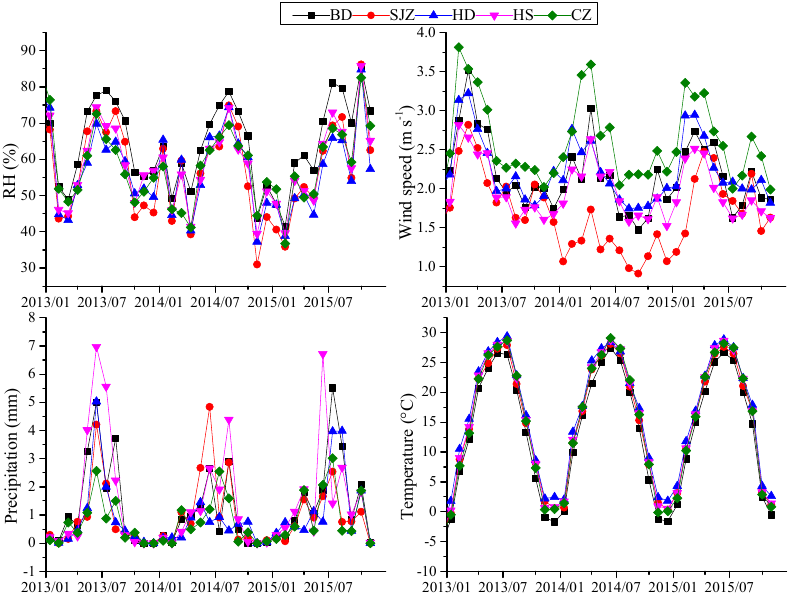
Figure 4. Monthly average meteorological factors in five cities during 2013–2015.